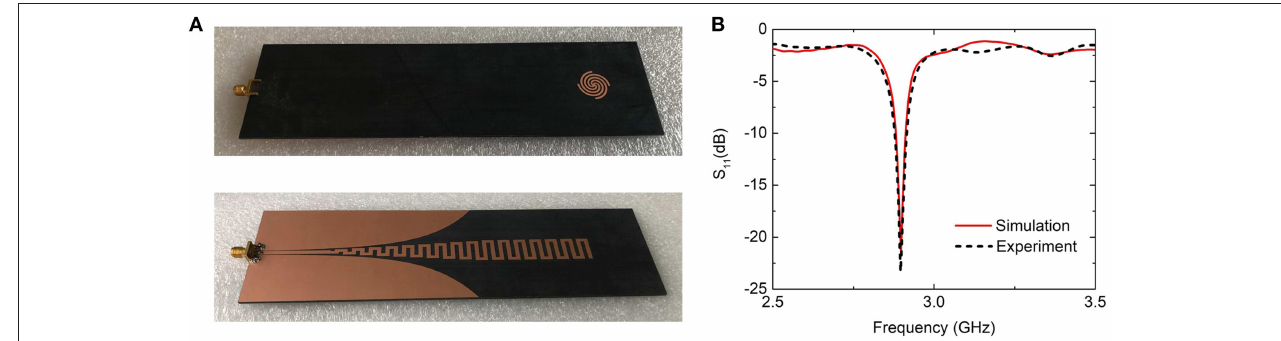
FIGURE 5 | (A) Photographs of the fabricated SSPPs waveguide feeding configuration and the plasmonic metamaterial antenna. (B) Comparison of scattering parameter results between simulation and experiment results for the antenna fed with the proposed SSPPs waveguide.